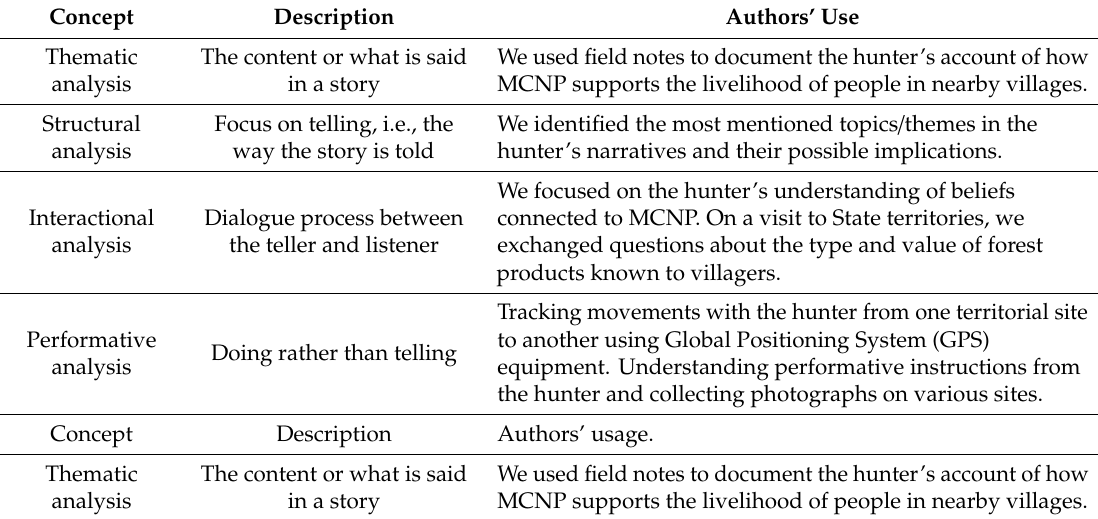
Figure 1. Location of sites on the Buea and West Coast of Mount Cameroon National Park (MCNP) where we collected data. Note, we designed the map using the points (P) collected on the Buea and West Coast clusters of MCNP during fieldwork. Table 1. Using Riessman’s [49] (p. 2–5) concepts in the narrative analysis of